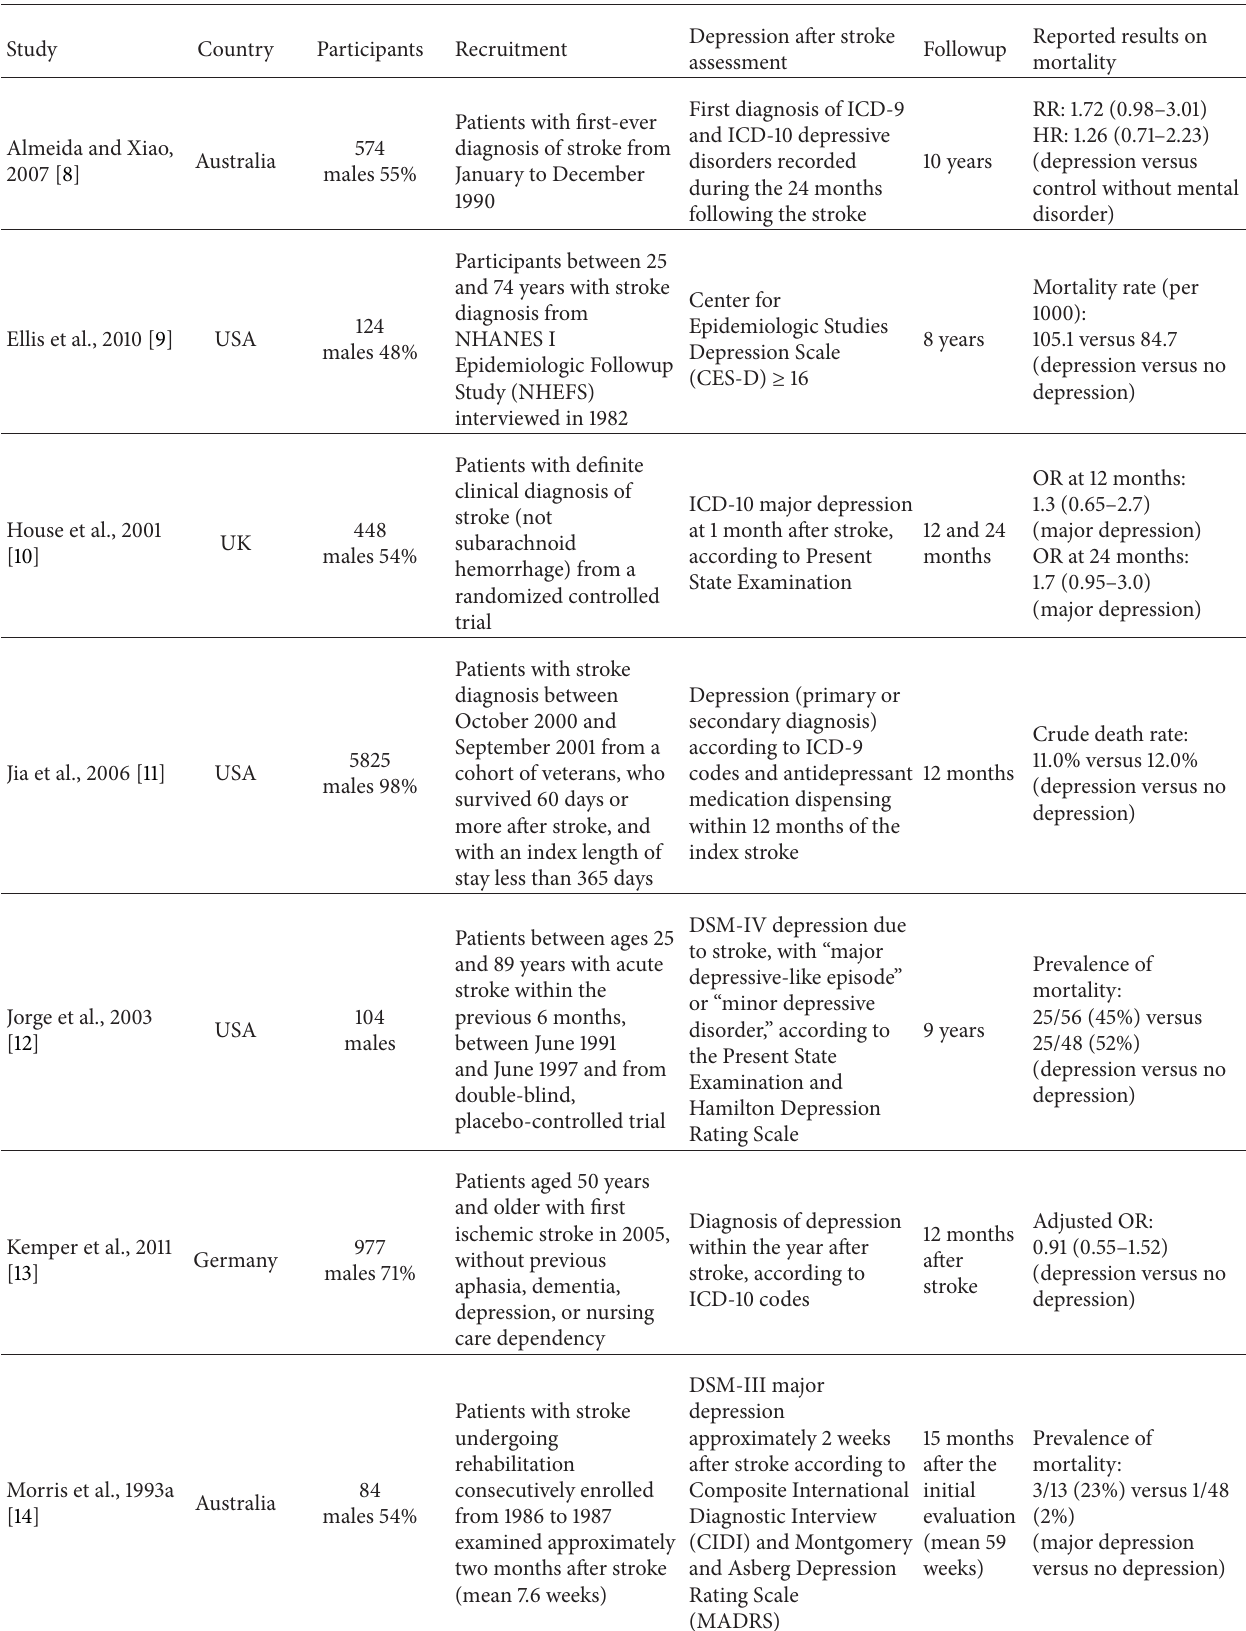
Table 1: Articles suitable for